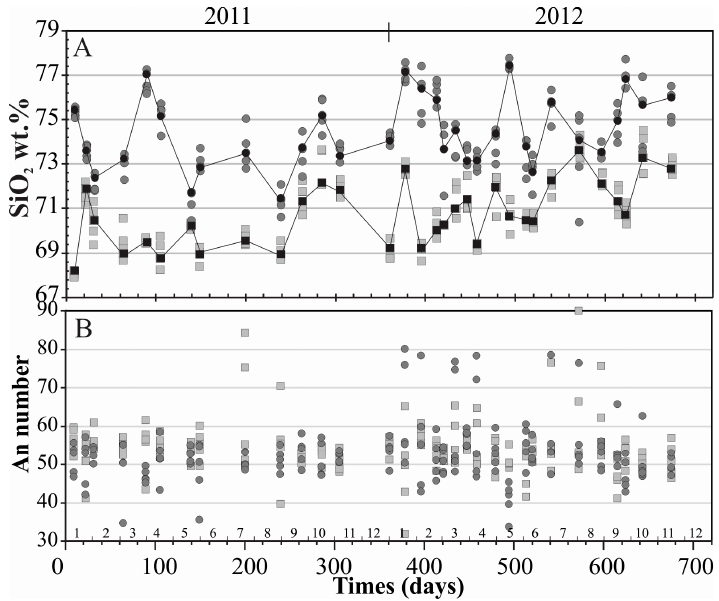
Figure 5. ( A ) the SiO 2 content of interstitial glass and ( B ) An numbers of BVVR (solid rectangle) and BVR (solid circle). In interstitial glass composition, for black solids, both of them are average